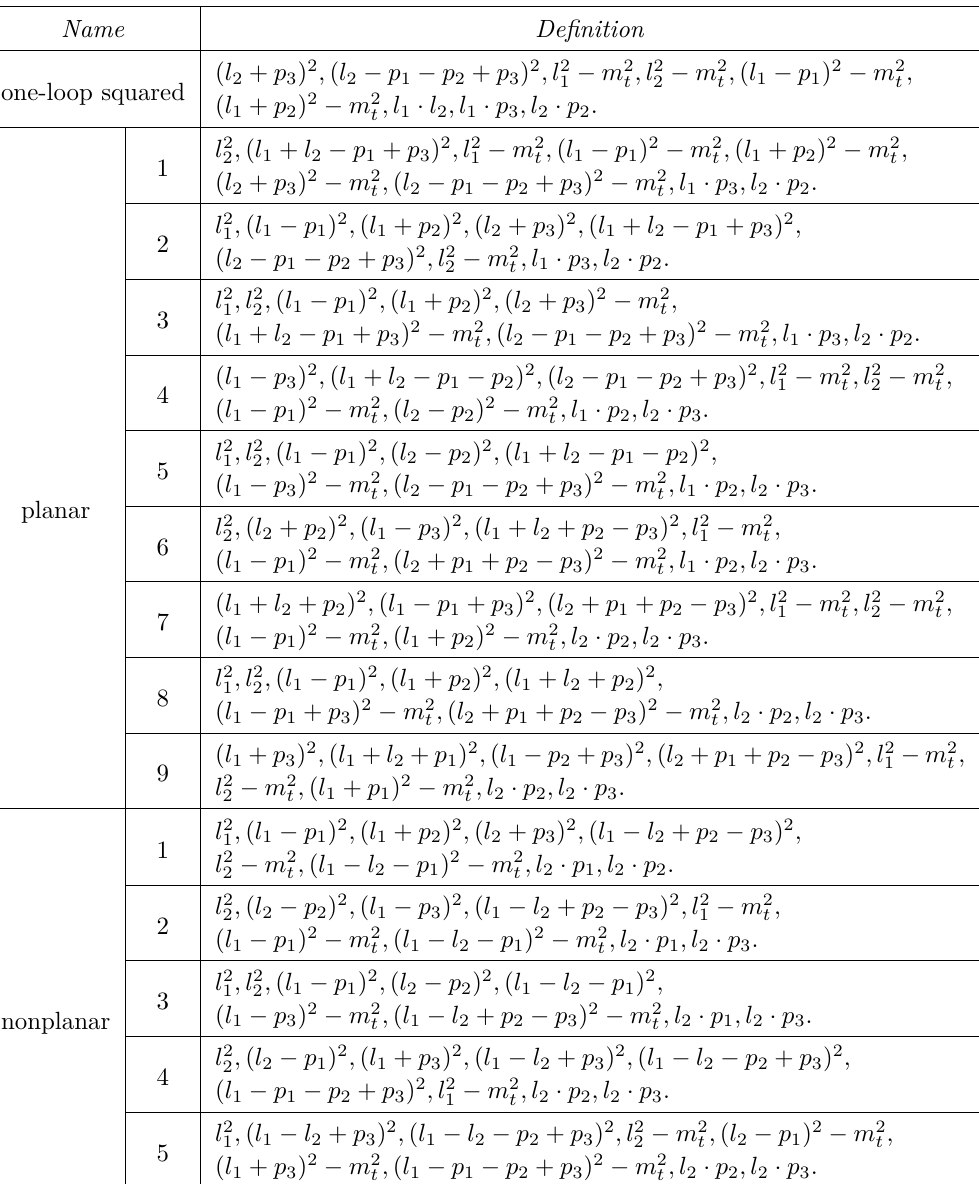
Table 6. Definitions of the integral families. l 1 and l 2 are loop momenta while p 1 , p 2 , and p 3 are external momenta defined in eq.